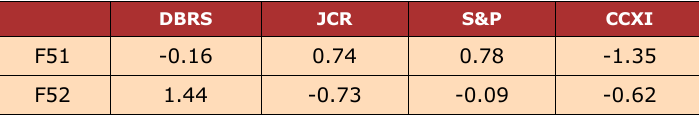
Table 13. The Scores of Principal Component (4)